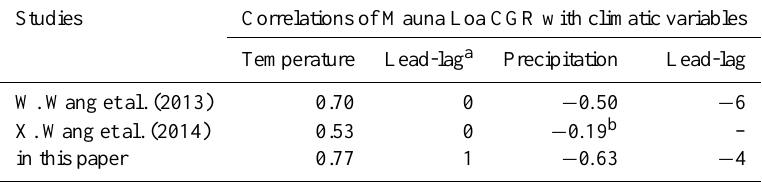
Table 2. Summary of previous studies of the relationships between Mauna Loa CGR and climatic variables. Studies